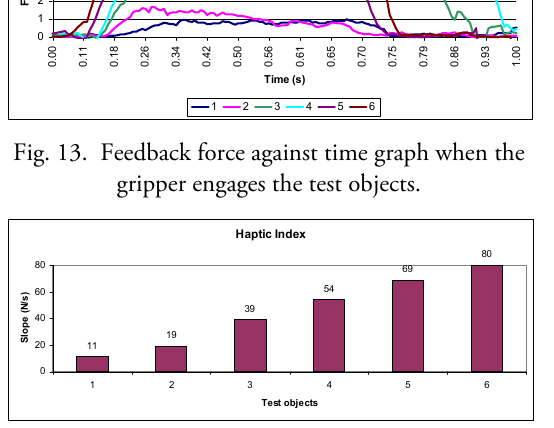
Fig. 14. Haptic index of the six test objects.